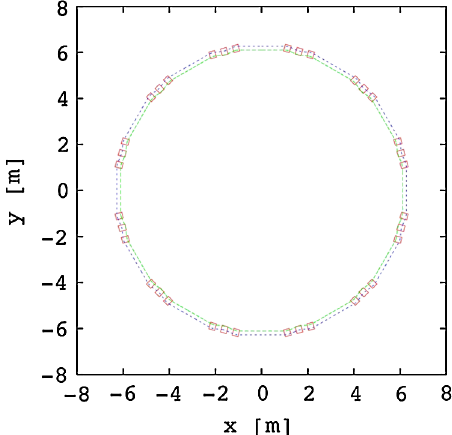
0.276FIG. 2. (Color) Footprint of a 12 cell FFAG. The red rectangles indicate the position of the magnets. Two dotted lines show orbits of 0 : 243 GeV =c (inside) and 0.729 (outside) GeV =c